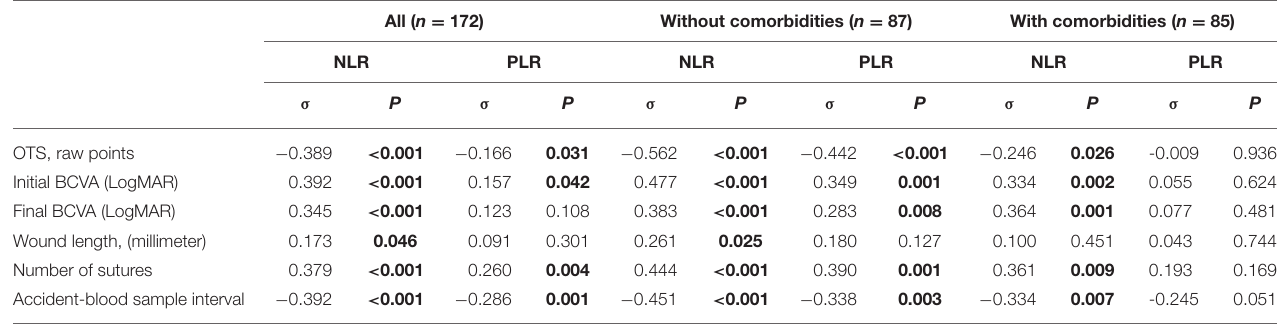
TABLE 5 | Spearman’s correlation coefficient between NLR and PLR and the studied variables. All ( n = 172) Without comorbidities ( n =